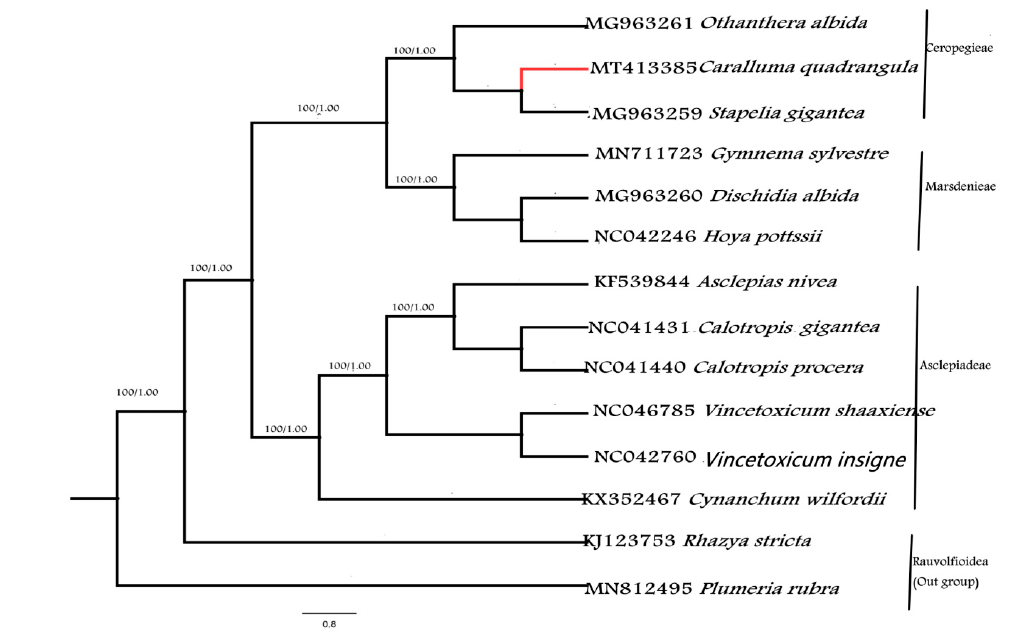
Fig. 9: Phylogenetic tree reconstruction of 14 taxa based on the complete chloroplast genome using Maximum Parsimony (MP) and Bayesian Inference (BI) methods, showing relationship within the fourteen species of Apocynaceae. The numbers in the branch nodes represent bootstrap percentage (BP)/ posterior probability